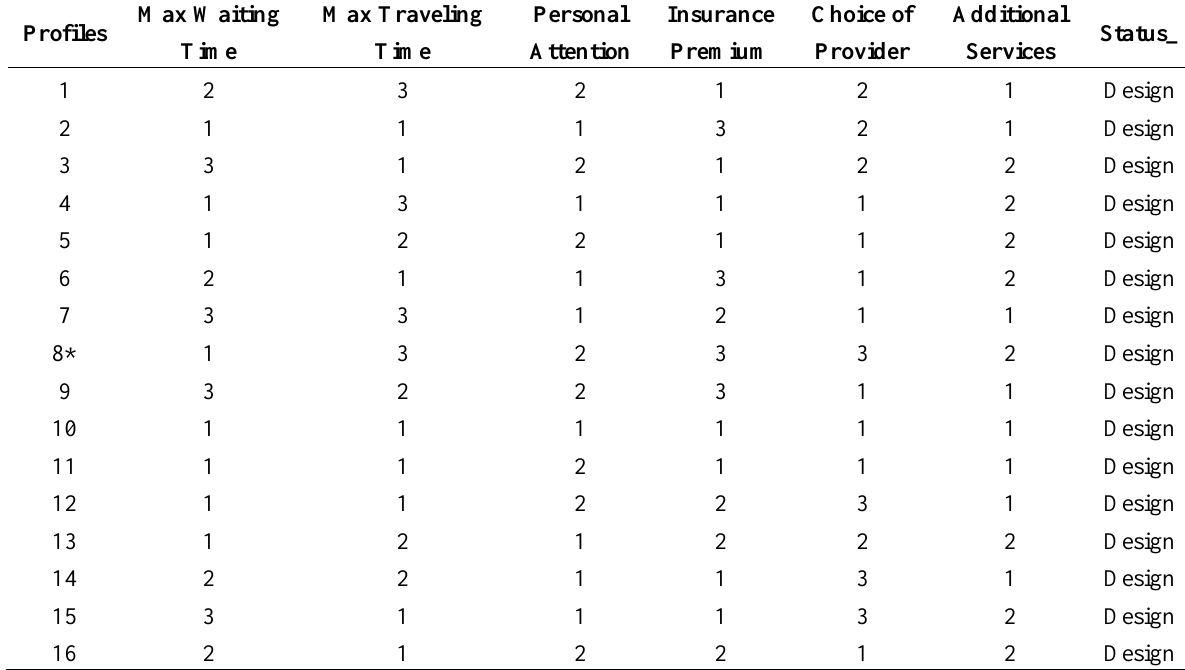
Table 2. Conjoint profiles (orthogonal main effect